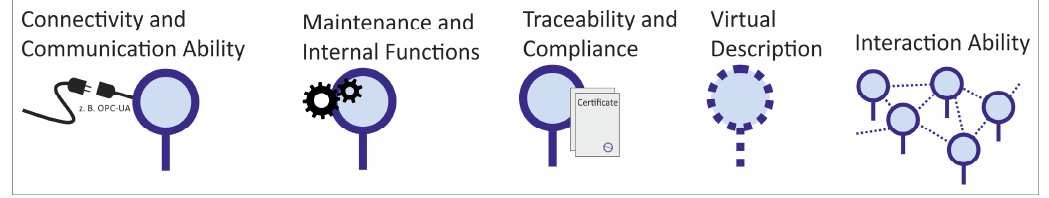
Figure 1. Most important features of a smart sensor or actuator